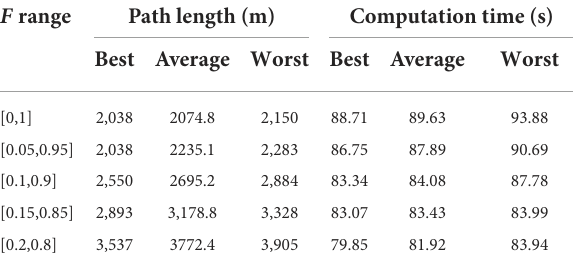
TABLE 7 Path planning results with different F range. F